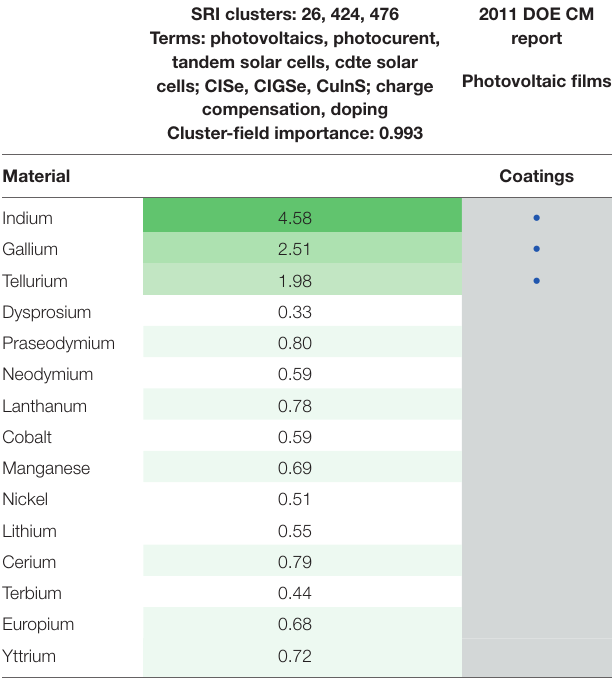
Table 1 | Materials/application pairing matrix comparing the results from our methodology with the Department of Energy (DOE)’s CM strategy report for the photovoltaic technology and coatings component.